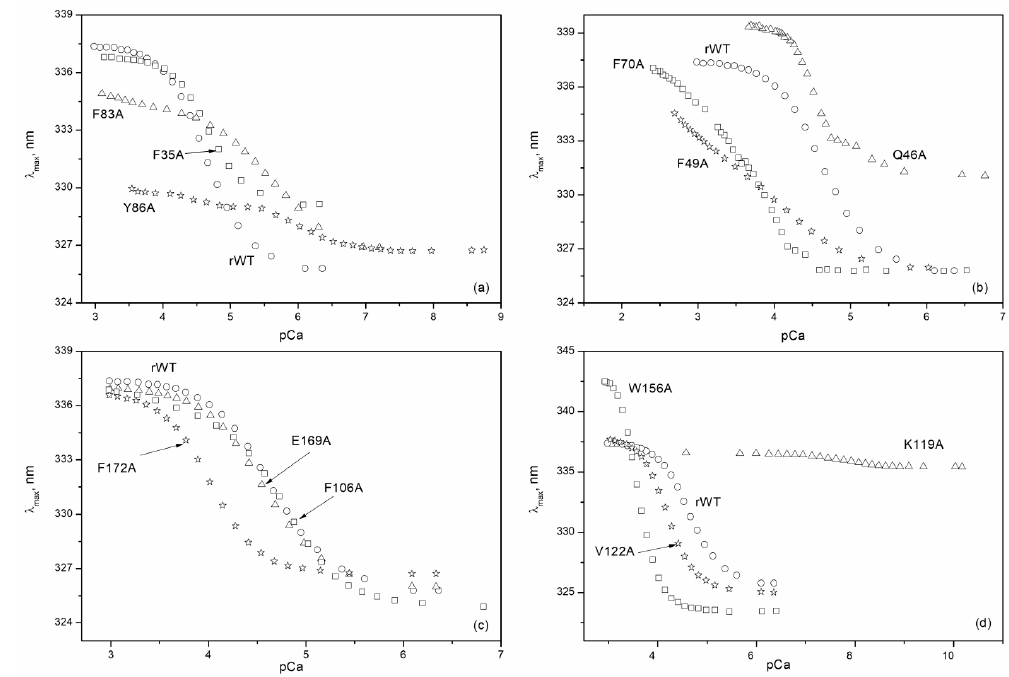
Figure 7. Ca 2 + -dependence of fluorescence spectrum maximum for rWT human recoverin and its cluster mutants (( a )—‘black’ cluster of the N-domain, ( b )—‘gray’ cluster of the N-domain, ( c )—‘black’ cluster of the C-domain, ( d )—‘gray’ cluster of the C-domain) at 20 ◦ C with the use of Ca 2 + -bu ff ers. The experimental data on calcium titrations of the most of recoverin forms were well approximated by theoretical curves computed according to both cooperative and sequential binding schemes (Table 4). Table 4. Logarithms of equilibrium calcium binding constants of rWT human recoverin and its cluster mutants at 20 ◦ C, evaluated according to the sequential and cooperative binding schemes using intrinsic fluorescence, calcium bu ff ers method and protein titration by Ca 2 +